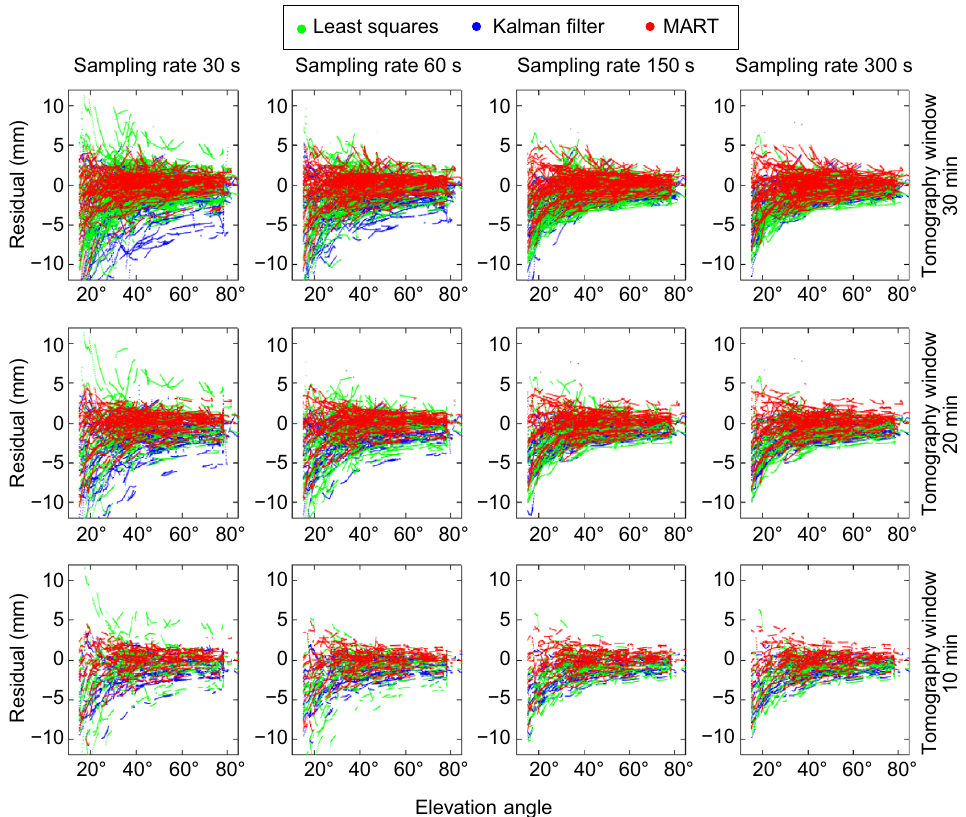
Fig. 4 Scatter diagram of the change of SWV residuals with elevation angle in three types of methods for different